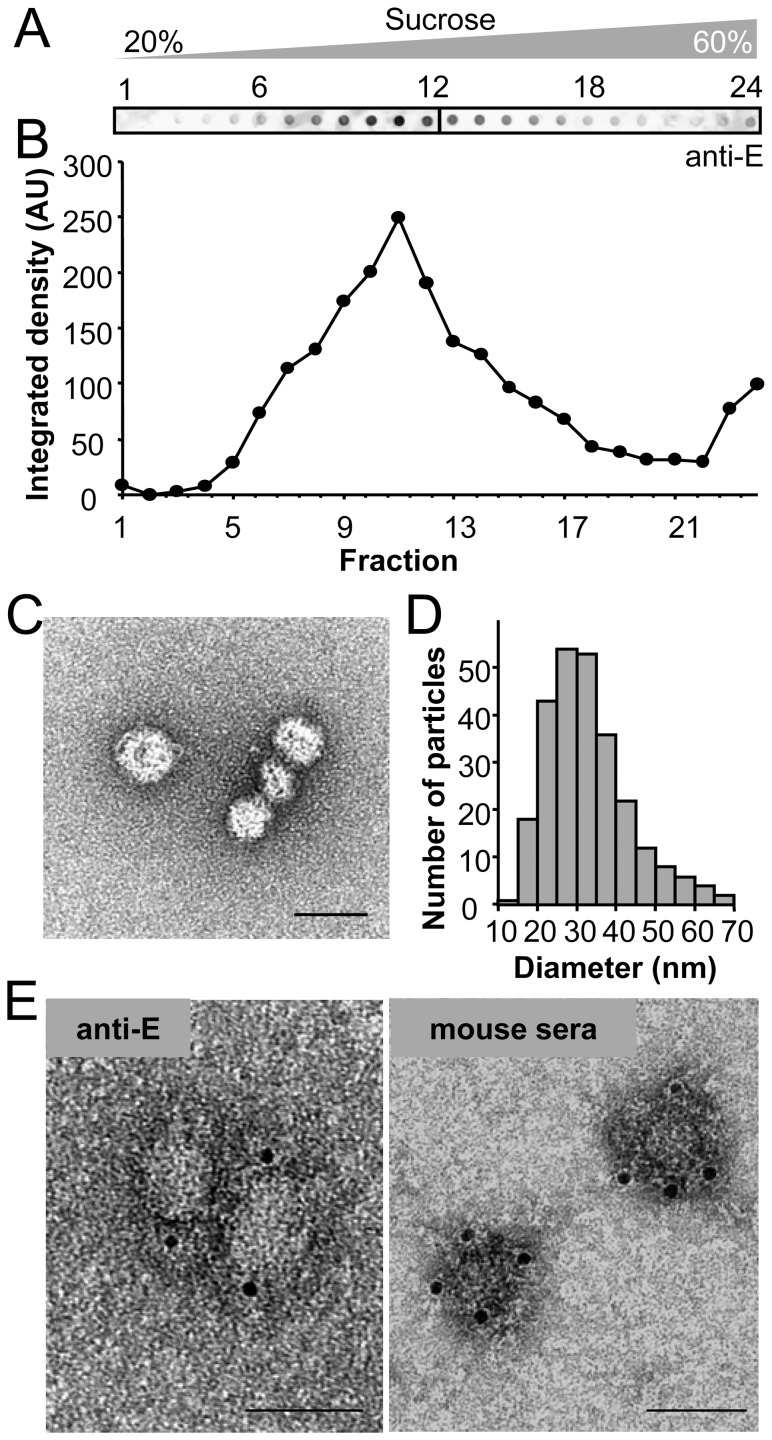
Structural analyses of WNV antigens secreted by HeLa3-WNV cells.(A) WNV proteins released to the culture medium of HeLa3-WNV cells were purified by centrifugation through a 20% sucrose cushion and loaded onto a 20–60% linear sucrose gradient. The amount of E glycoprotein in each fraction of the gradient was determined by enzyme-linked immunodot assay using a monoclonal antibody against the WNV E protein. (B) Quantification of the integrated density in each dot corresponding to the gradient fractions shown in panel (A). (C) Negative stained TEM image of purified WNV RSPs contained in peak fraction 11 of the gradient in panel (A). Scale bar: 50 nm. (D) Histogram showing the diameter of a total of 259 RSPs visualized by transmission electron microscopy and negative staining as in panel (C). (E) Purified RSPs were immunolabelled with either a monoclonal anti-E (left panel) or a pooled sera from WNV-infected mice (right panel), incubated with protein A or anti-mouse IgG coupled to 5 nm diameter colloidal gold. Samples were negatively stained and observed by transmission electron microscopy. Scale bars: 50 nm.